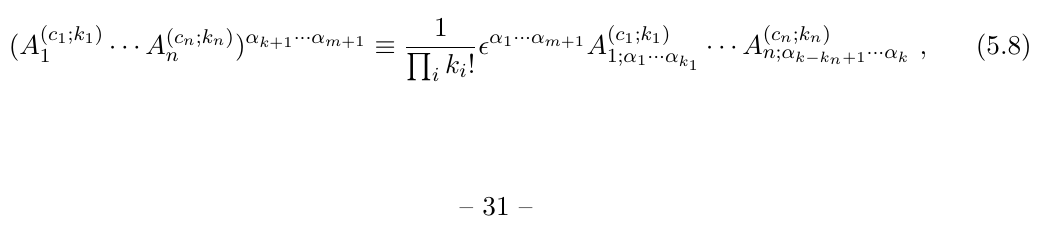
Figure 6. Quivers for Y 1 ; 0 ( P m ) with 1 (cid:12)elds of degree 0, 1, 2 and 3,